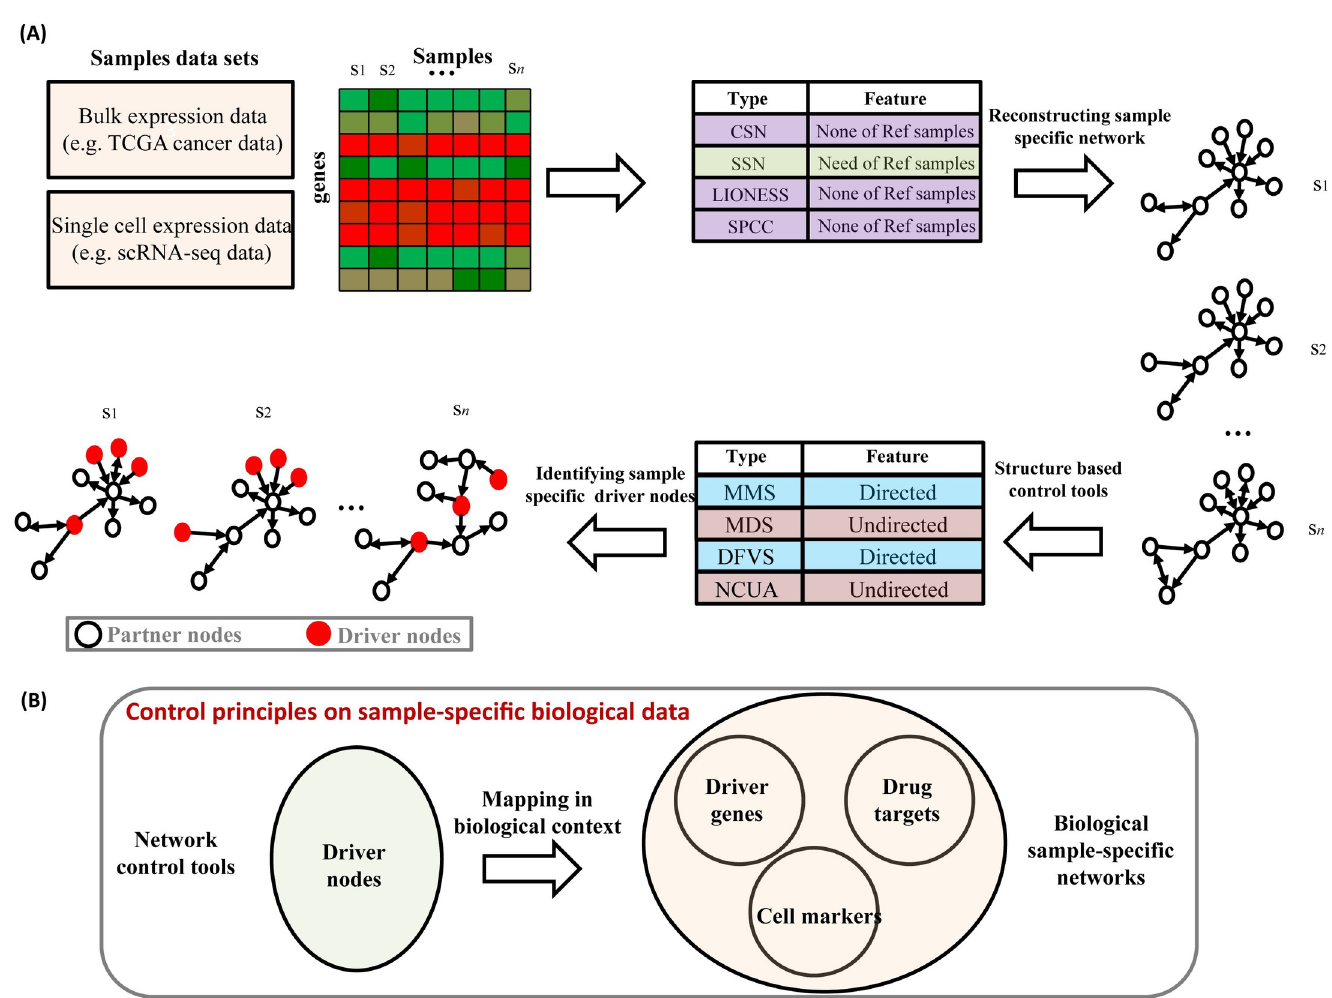
Fig 1. Overview of the Sample-Specific Control problem (SSC). (A) The flowchart of SSC analysis. The process of SCC analysis consists of two steps. The first step is to construct the sample-specific state transition network from the sample datasets. For constructing the sample-specific state transition network, several